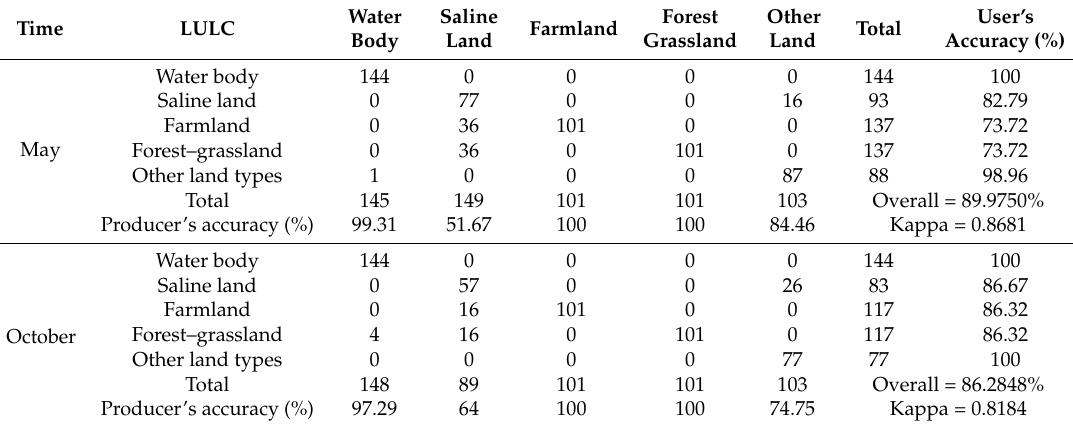
Figure 7. The area of land use/cover for each cluster. Table 2. The confusion matrix calculation with a maximum likelihood supervised